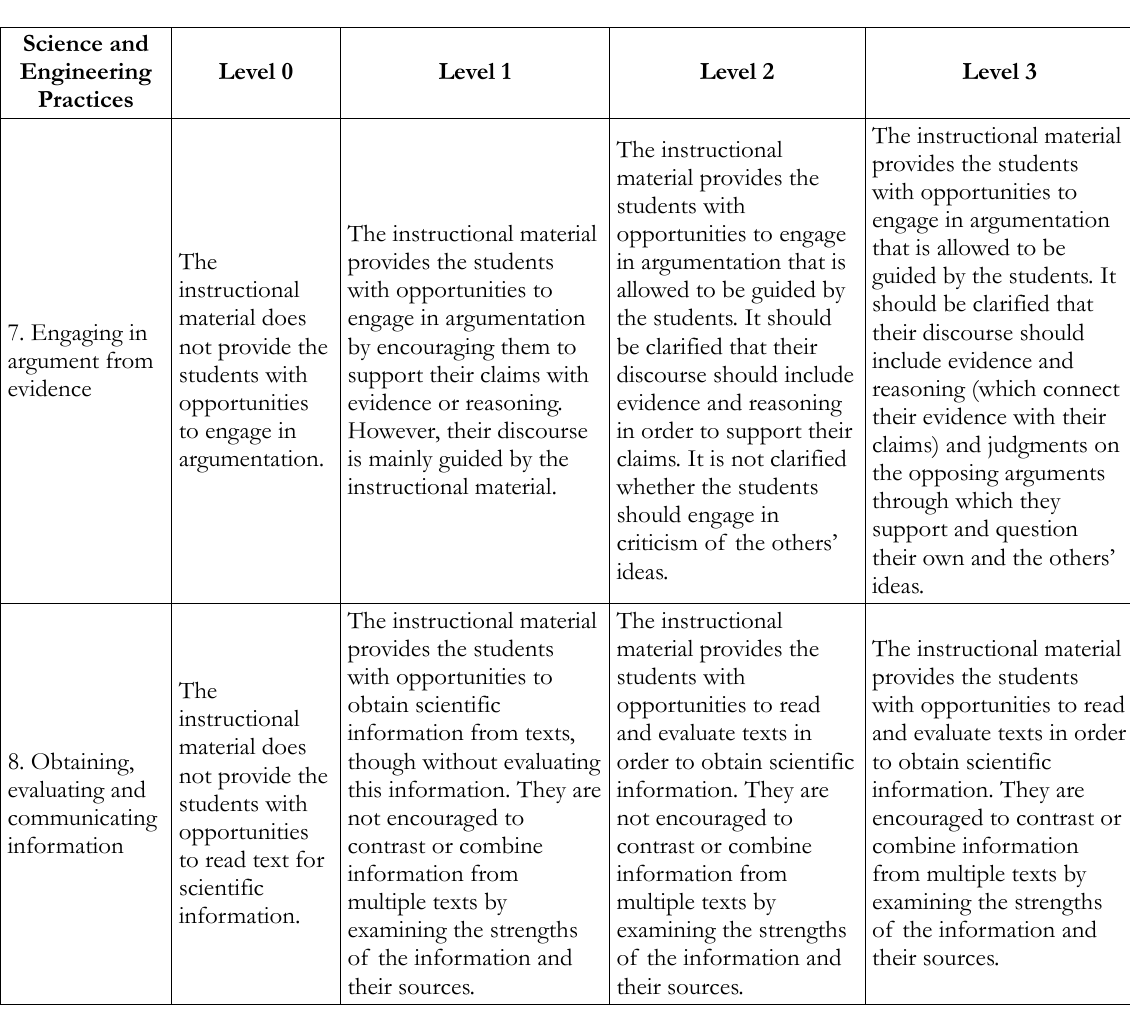
Table 1. Science and Engineering Practices Analytic Rubric